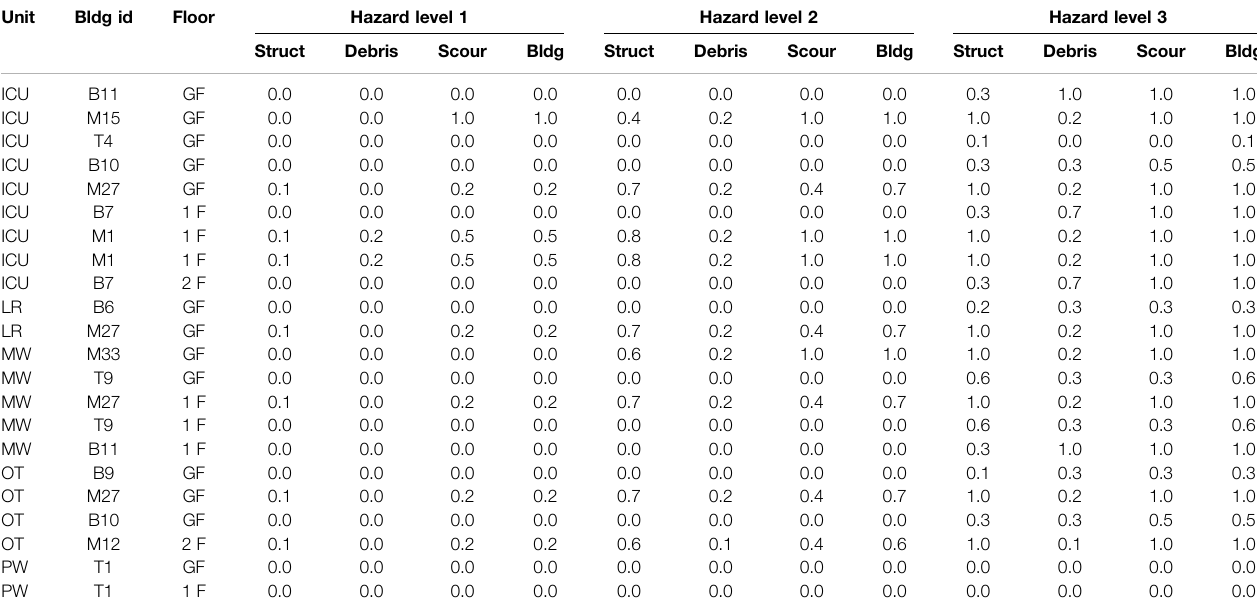
TABLE 5 | Summary of RRI bldg calculated for the critical units under three hazard